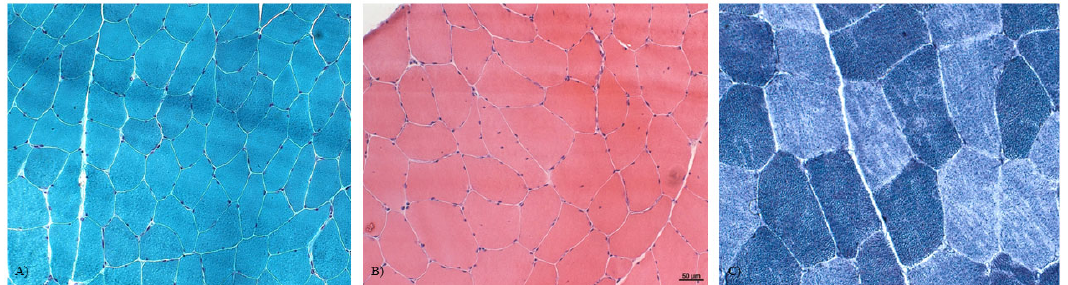
Figure 6. Myopathic changes in patients with RYR1 alteration. ( A ) Gomori trichrome staining showing some mild variation in fiber size and an increased number of fibers with internal nuclei in Pt 14. ( B ) Hematoxylin and eosin staining demonstrating the variation of fiber sizes, and multiple internal nuclei in some fibers in Pt 12. ( C ) NADH stain showing multiple minicores in some fibers. 40× magnification.